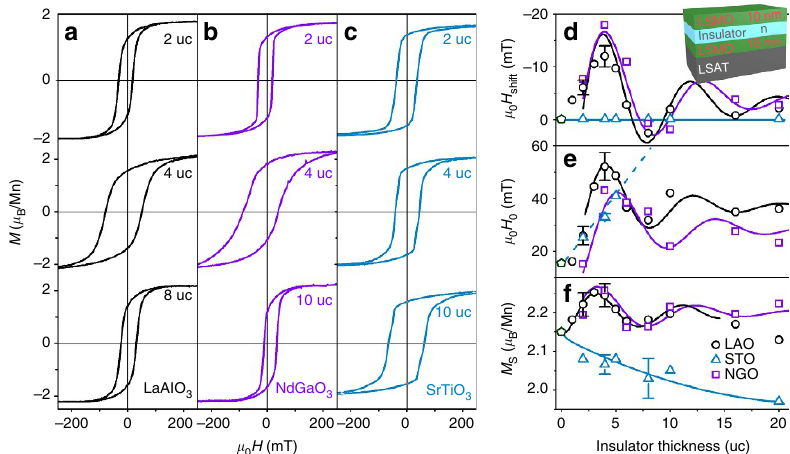
Figure 3 | Heterostructures with polar and nonpolar insulators. ( a ) LaAlO 3 . ( b ) NdGaO 3 and ( c ) SrTiO 3 . ( d – f) The variation of horizontal shift of the M–H loop ( H shift ), coercivity ( H c ) and saturation magnetization ( M s ) as a function of insulator thickness. The data are measured at